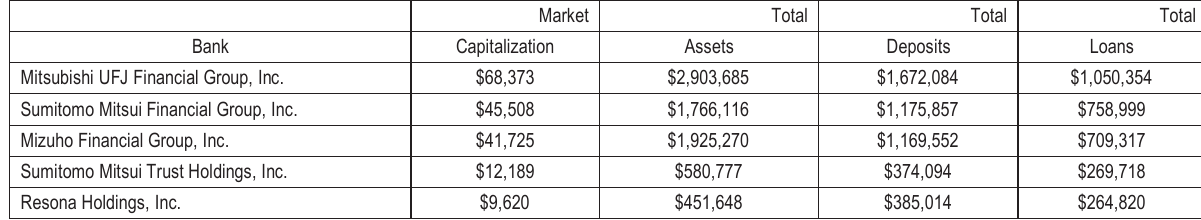
Table 3. Descriptive Statistics. Largest 20 Japanese Banks (in terms of market capitalization)